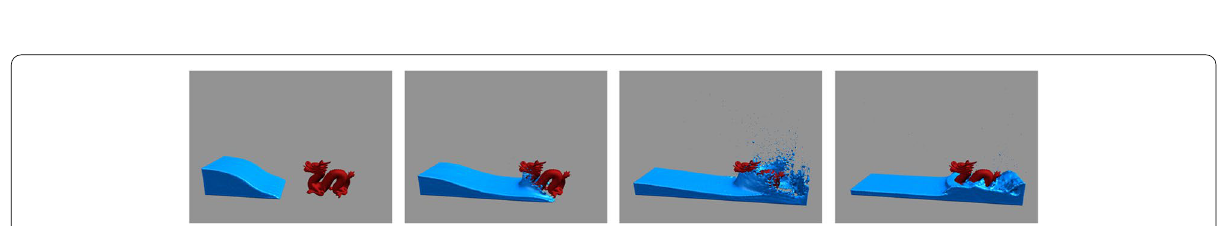
Fig. 8 Visual simulation of a fluid scouring a dragon-shaped obstacle, using the VSLSPH method (117649 particles)